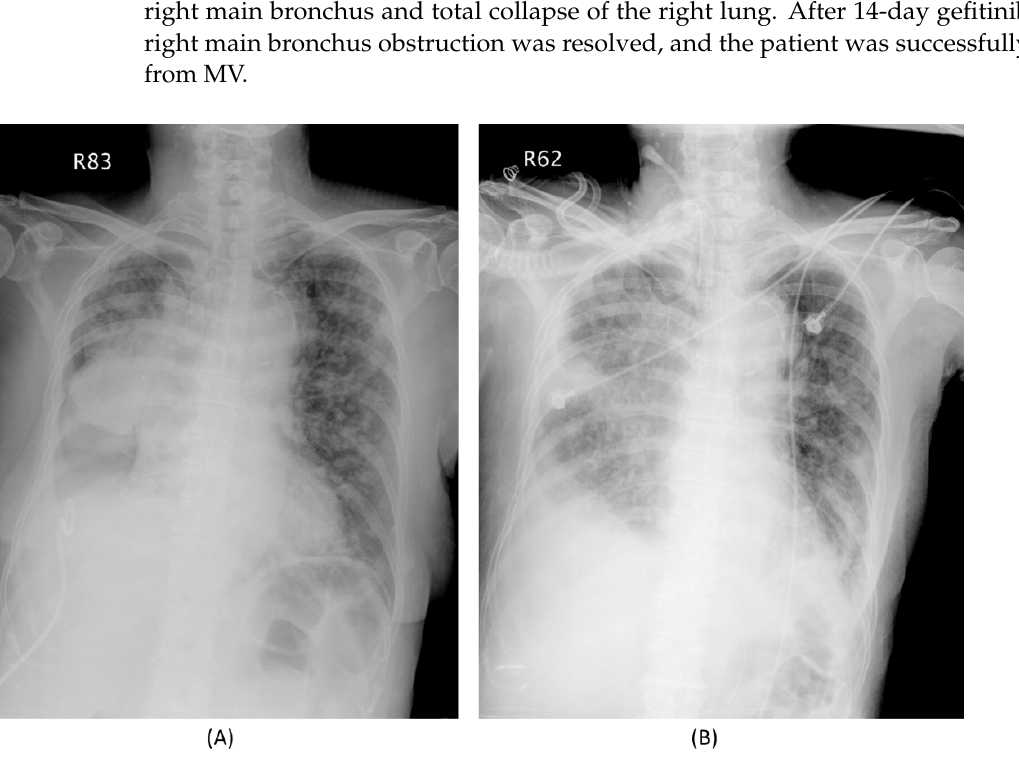
Figure 3. Case of a patient who experienced a dramatic response to EGFR-TKI during ICU treatment. This 72-year-old woman had right lung adenocarcinoma, cT4N3M1c, stage IVB, with malignant pleural effusion, lung-to-lung, liver, and adrenal metastasis. She suffered from an episode of pneumonia and hypercapnic respiratory failure, and was admitted to the ICU for intensive care. The plain film before ( A ) and 2 weeks after gefitinib ( B ) are shown. The patient finally was weaned successfully from the mechanical ventilator and discharged home with tracheostomy under ambient air. Acronyms: EGFR = epidermal growth factor receptor, ICU = intensive care unit, TKI = tyrosine kinase inhibitor .